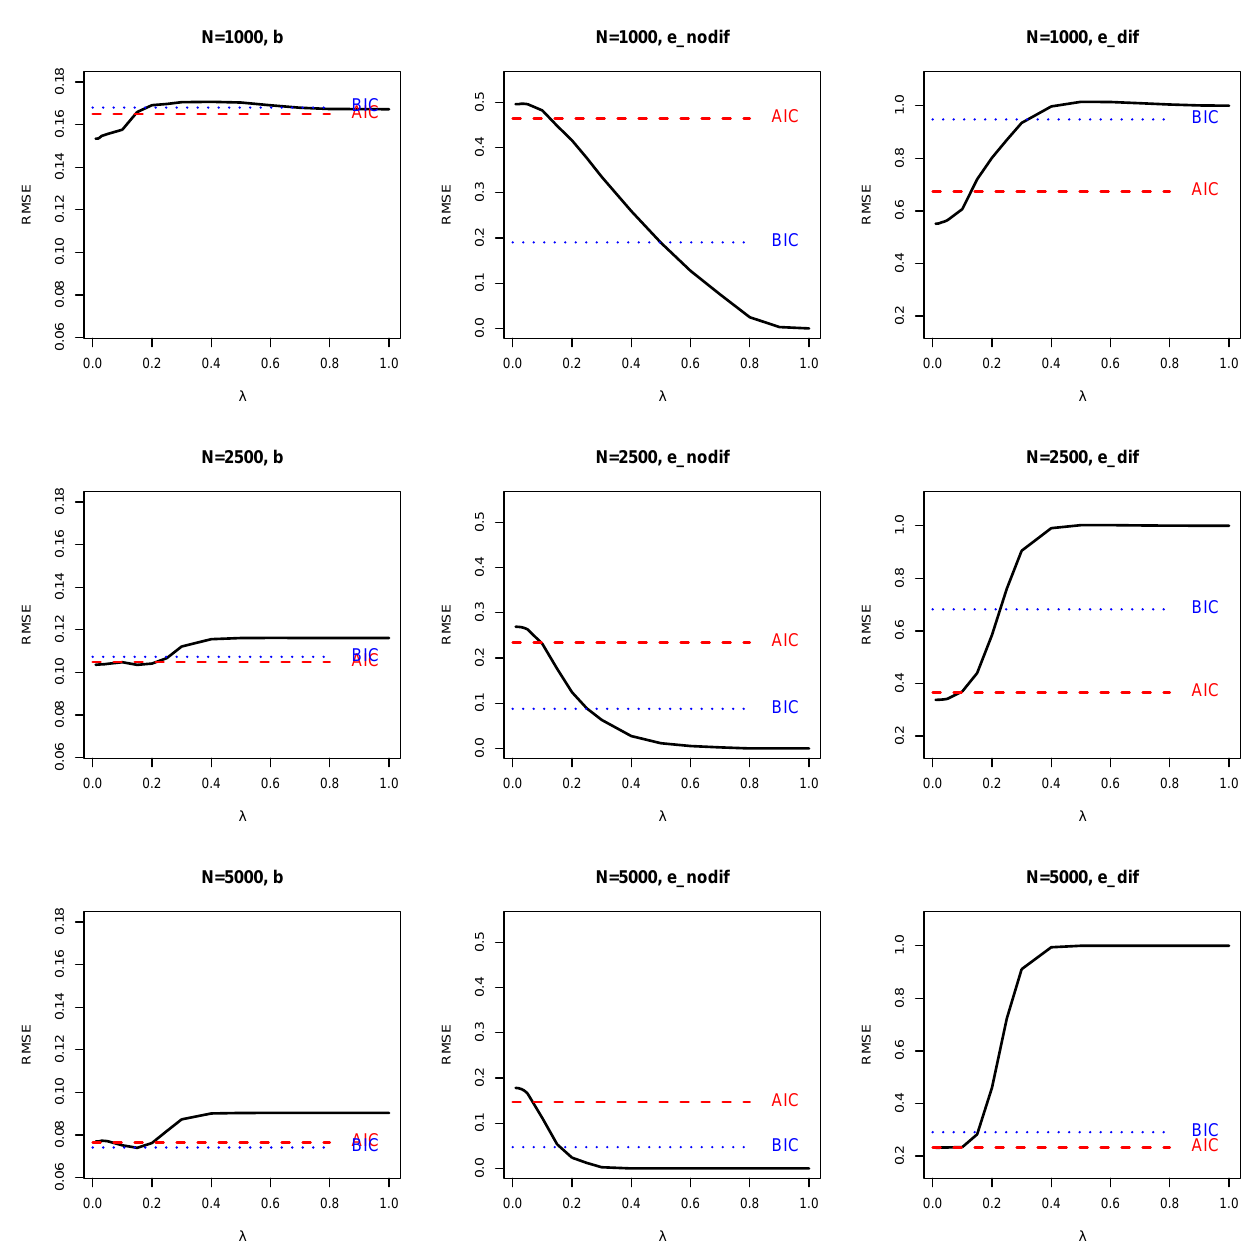
Figure 3. Simulation Study 1: Average RMSE for parameter groups of item difficulties b i ( b ), DIF effects e i with true values of zero ( e_nodif ), DIF effects e i with true values different from zero ( e_dif ) as a function of a fixed regularization parameter λ and optimal regularization parameters obtained from AIC or